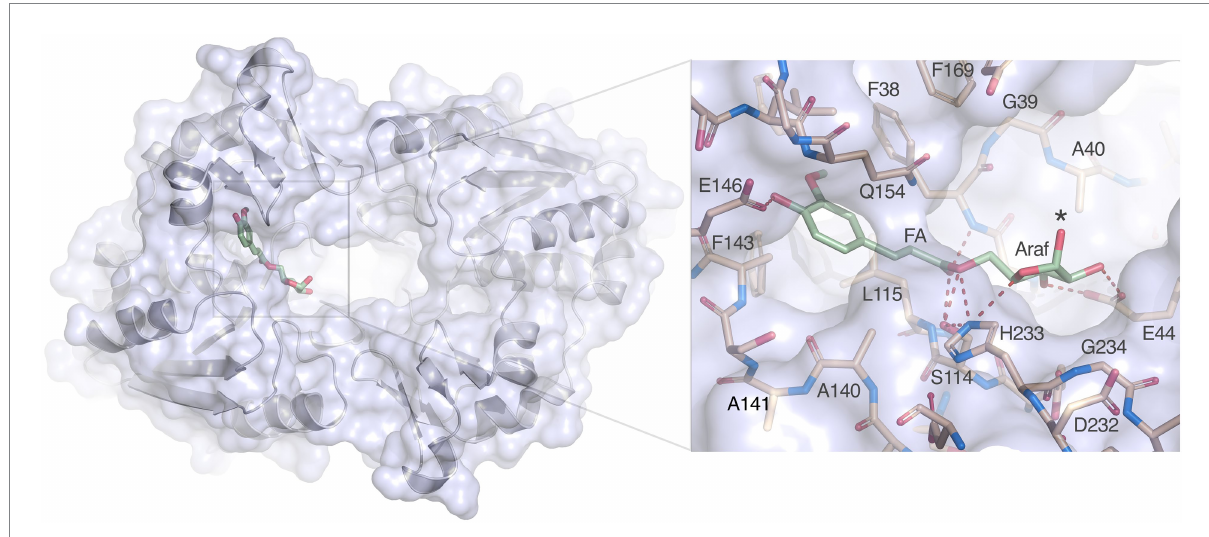
FIGURE 8 Docking of arabinofuranosyl ferulate. Arabinofuranosyl ferulate (Araf-FA; green) docked in the active site of Lb FAE. The view is from the bottom of the homodimer where the entrance to the active site is located. The arabinofuranosyl moiety is exposed to the opening at the dimer interface. The inset shows possible hydrogen bonds between the ferulate and arabinofuranosyl moieties as dashed red